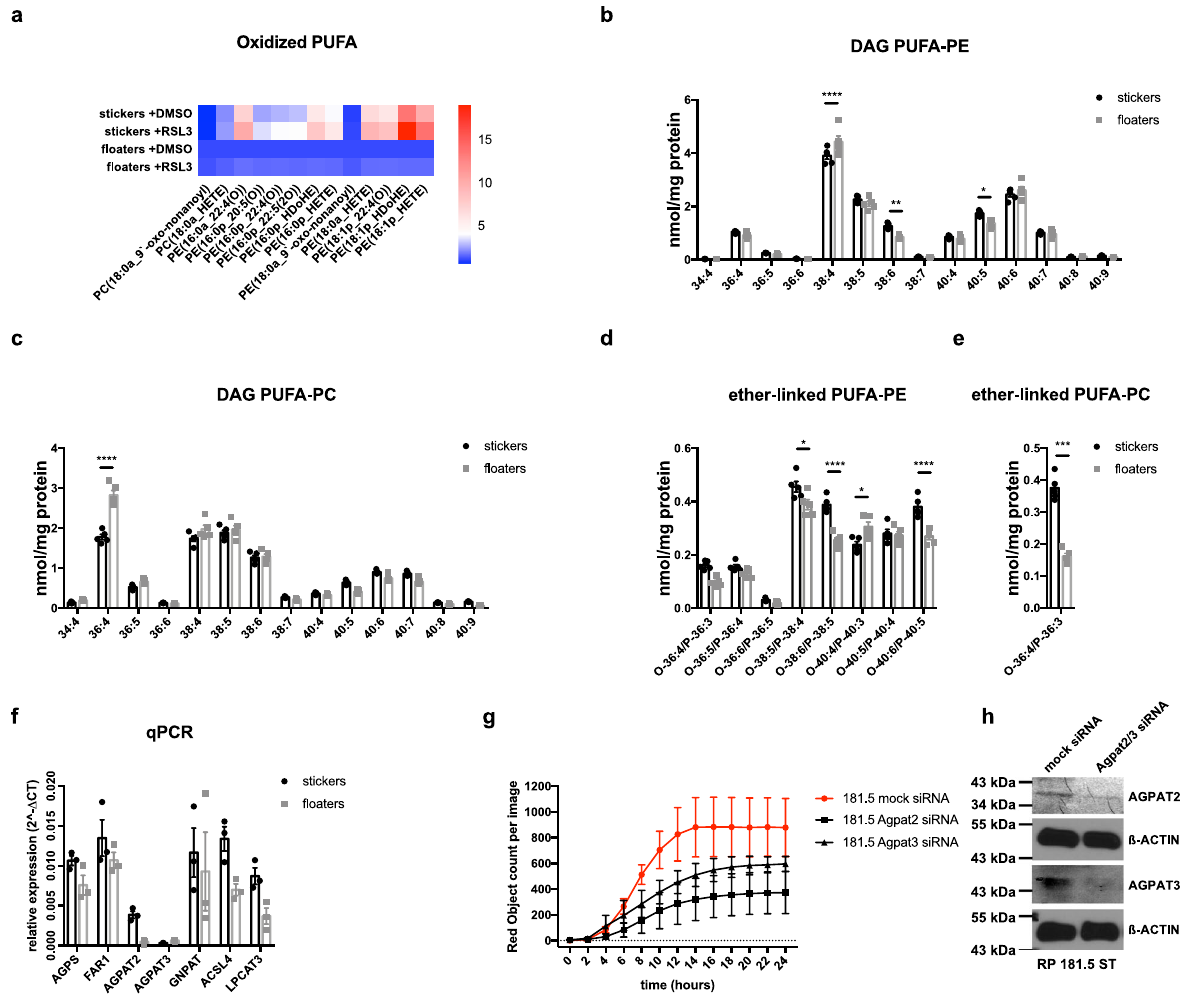
Fig. 4 non-NE/NE SCLC subtypes undergo lipid metabolism remodeling. a Heatmap showing the representation of mono-oxidized phospholipid species (PE phosphatidylethanolamine; PC phosphatidylcholine) in 181.5 stickers as compared to 181.5 fl oaters treated with either DMSO or RSL3 [1 µ M] for 5 h and then subjected to lipidomics. Samples for each condition ( n = 5) were averaged and normalized to the cell number (2.5 × 10 6 ). Each lipid species was normalized to levels detected in fl oaters + DMSO. One representative out of two independent experiments is shown. Heatmap color code indicates normalized lipid species levels of each sample. b – e 181.5 stickers fl oaters ( n = 5 samples) as compared to 181.5 fl oaters ( n = 5 samples) were analyzed for basal diacylglycerol (DAG) and ether-linked lipids by mass spectrometry. Lipid content was normalized to infused protein for each condition and replicate. Individual PUFAs (4 double bonds or more) are plotted. f RNA was isolated from three stickers / fl oaters lines (RP181.5; RP246.7; BYC5.1), respective cDNA obtained and qPCR performed for the indicated transcripts. g RP181.5 were subjected to the indicated siRNA-mediated knockdowns for 72 h and then treated with RSL3 [1 µ M] for an additional 24 h. DRAQ7 [0.1 µ M] was added to all wells to visualize dead cells. Images were acquired every 2 h using the IncuCyte S3 bioimaging platform. Dead cells/image are normalized to cell con fl uence at the beginning of RSL3 treatment. h Representative western blots are shown. Data are means ± SEM of three independent experiments or representative images if not indicated otherwise. Two-tailed unpaired t tests ( e ) Two-way ANOVA + Tukey ’ s multiple comparison test, **** p < 0.0001, *** p < 0.001, ** p < 0.01, * p < 0.05. Source data are provided as Source data fi These data indicated that cell death induced by this treatment fractional killing via ferroptosis may select for NE cells over time while, vice versa, TRX pathway inhibition might enrich tumors (blocked by Ferrostatin-1) and, thereby, partially ferroptotic and for non-NE SCLC cells. Moreover, single pathway targeted treatment-induced plasticity will equally enable escape of SCLC subtypes by transdifferentiation. To pre-empt fractional killing and selection as well as non-NE/NE plasticity under treatment, we evaluated the extent of synergistic killing by combined BSO/ Aurano fi n in non-NE and NE SCLC cells. Indeed, combined BSO/Aurano fi n treatment induced very effective cell death in both subtypes (Supplementary Fig. 8b, c). When combining sublethal doses of Aurano fi n with BSO, cell death could only be reverted by combined Ferrostatin-1 and N-acetylcysteine treat- ferroptosis escape within the 48 h window of the knockdown via ment (NAC) (Supplementary Fig. 8d, e), the latter of which is a alternative use of the TRX pathway for anti-oxidant defense. general antioxidant with poor ef fi ciency against ferroptosis 51,65 .